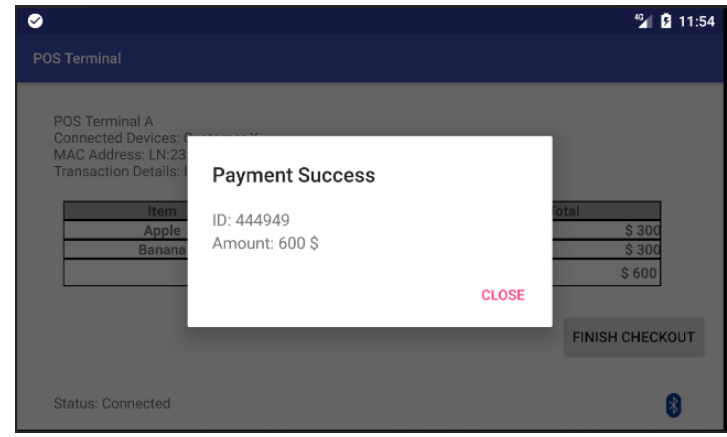
Figure 11. The POS terminal screen displays a notification of successful payment transaction in our prototype system.